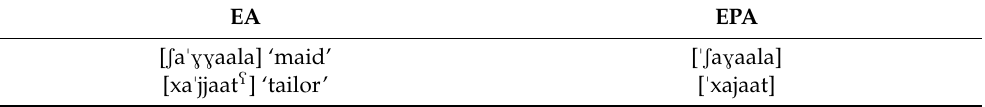
Table 5. The shift of the stress into the first syllable in the case of degemination.